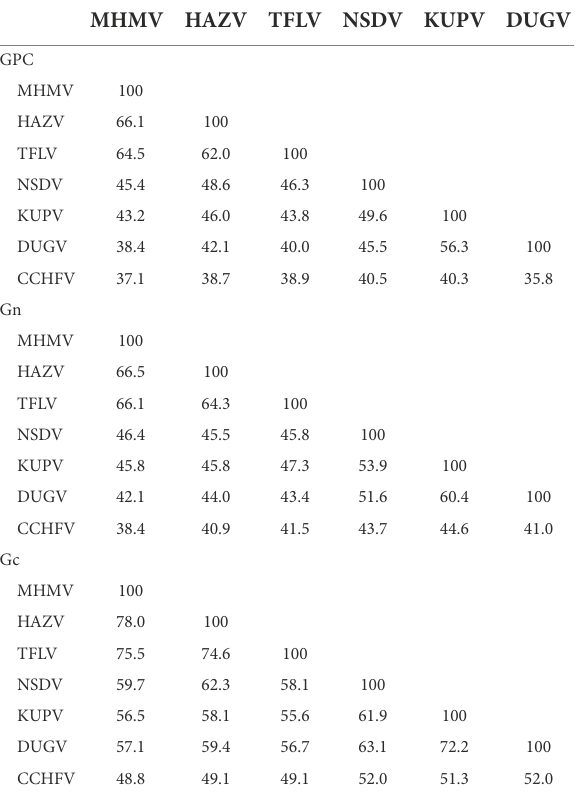
TABLE 2 Pairwise comparisons of GPC, Gn, and Gc amino acid sequences among the NSD genogroup orthonairoviruses. Amino acid sequence identity (%)